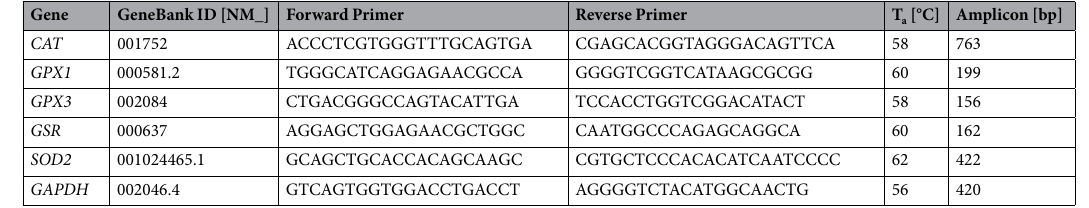
Table 1. Primer sequences and PCR